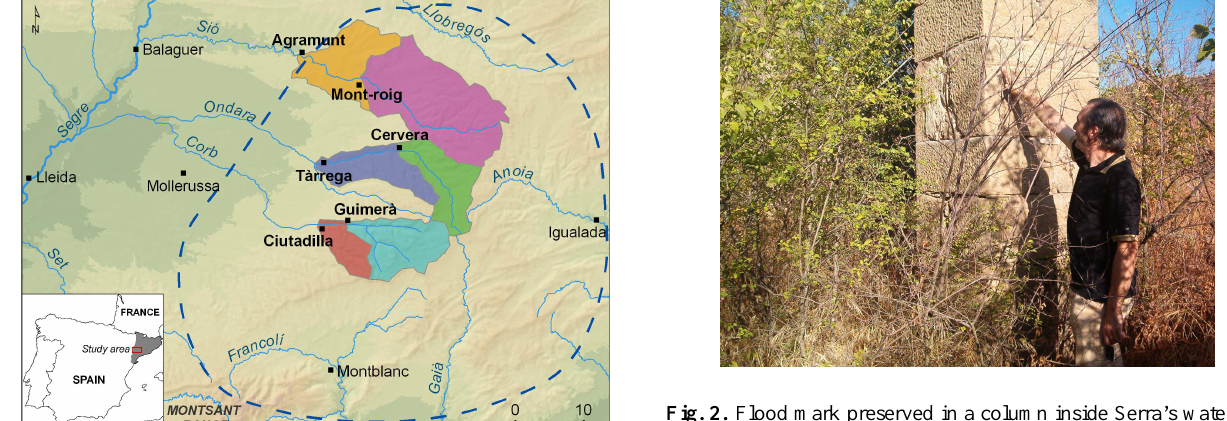
Fig. 2. Flood mark preserved in a column inside Serra’s watermill remains at Mont-roig by the Si´o